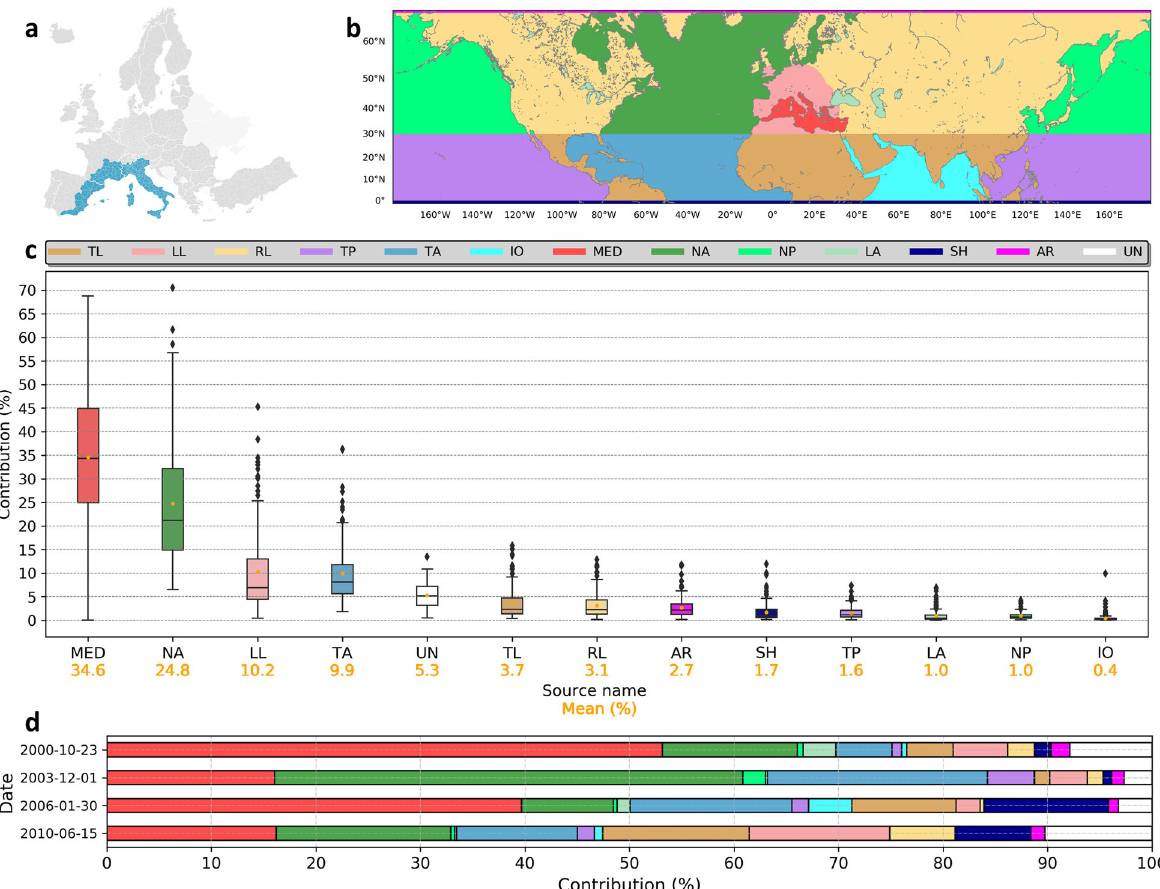
Fig. 1 Precipitation fractions from the different sources. a Region of study in which the extreme precipitation episodes were detected. b Simulation domain and the 12 moisture sources analyzed, which are represented with different colours. All sources are of 2D type, except for those on the northern (magenta) and southern (dark blue) boundaries, which are of 3D type (see Methods section). c Box diagrams for the 160 simulated events according to the moisture source: Tropical Land (TL), Local Land (LL), Remote Land (RL), Tropical Paci fi c (TP), Tropical Atlantic (TA), Indian Ocean (IO), Mediterranean (MED), North Atlantic (NA), North Paci fi c (NP), Lakes and Inland Seas (LA), Southern Hemisphere (SH) and Arctic (AR). The abbreviation UN refers to moisture of unde fi ned origin. The orange dot on the diagrams and the orange number on the x -axis show the average contribution of each source for the 160 cases. d Cumulative bar chart with contributions from all sources in four representative cases. The y -axis shows the date on which these episodes